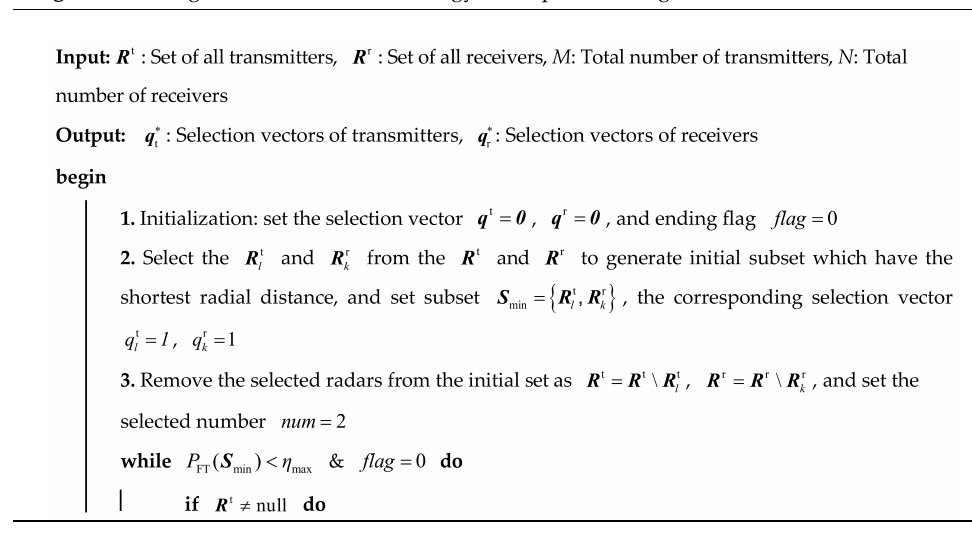
Algorithm 1: Algorithm of Selection Strategy for Rapid